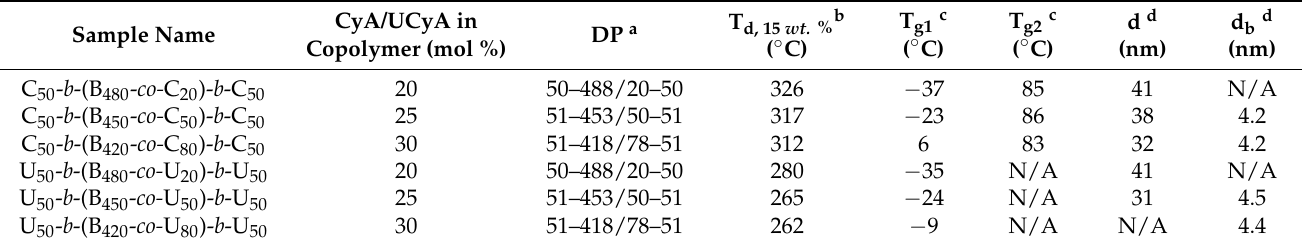
Table 1. Compositions, thermal properties, and morphological properties of CyA and UCyA copolymers with varying amounts of hydrogen bonding